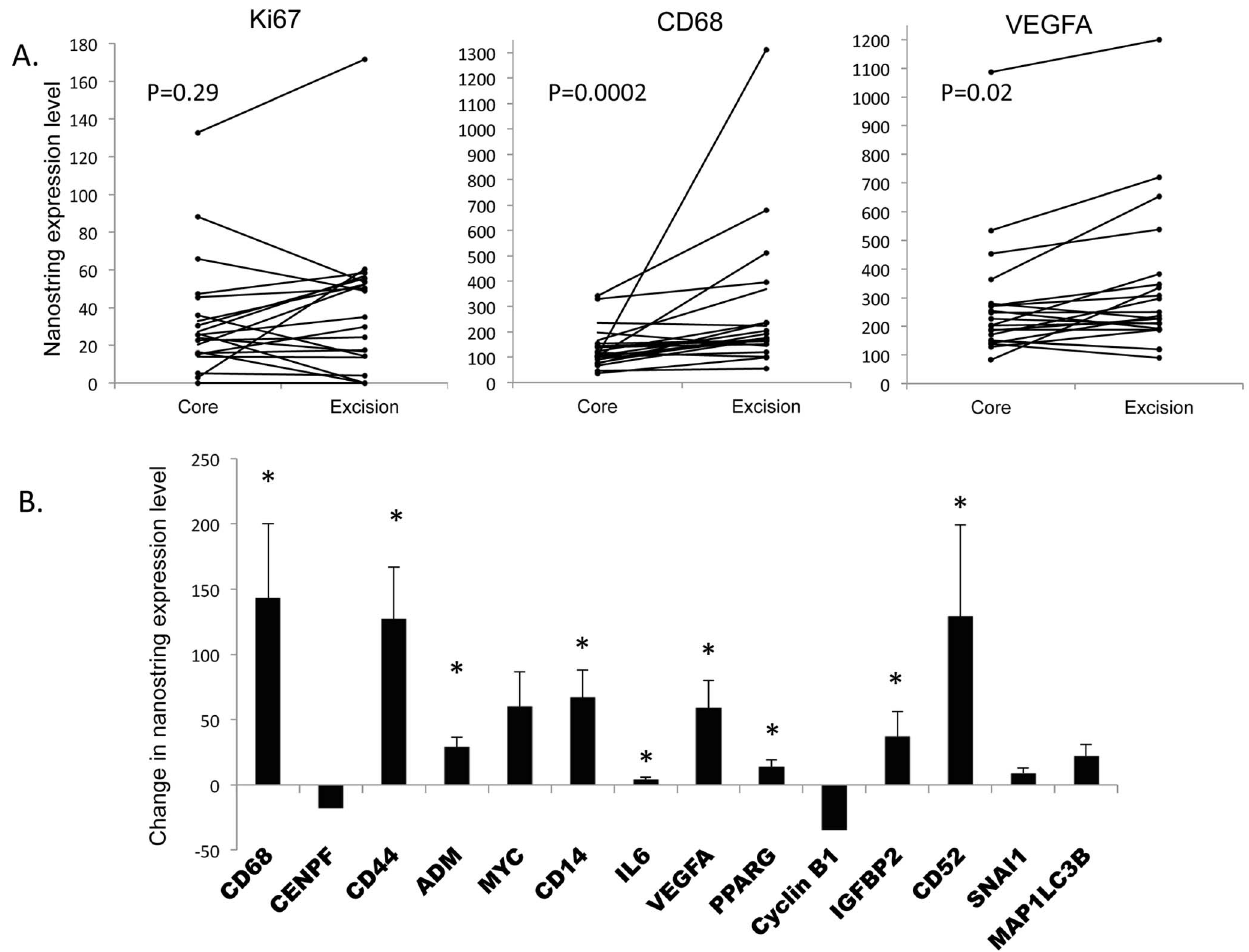
Figure 5. Changes in the expression levels of immune related genes between CNBs and EBs. A. Individual patient plots (n=21) for NanoString expression level at the time of the CNB and EB for Ki67, CD68, and VEGFA. P-values are from Wilcoxon signed rank tests. B. Bar graph represents the Nanostring expression value differences between the CNB and EBs for all the genes that had a statistically significant change (by Wilcoxon signed rank tests). * denotes genes with immune related